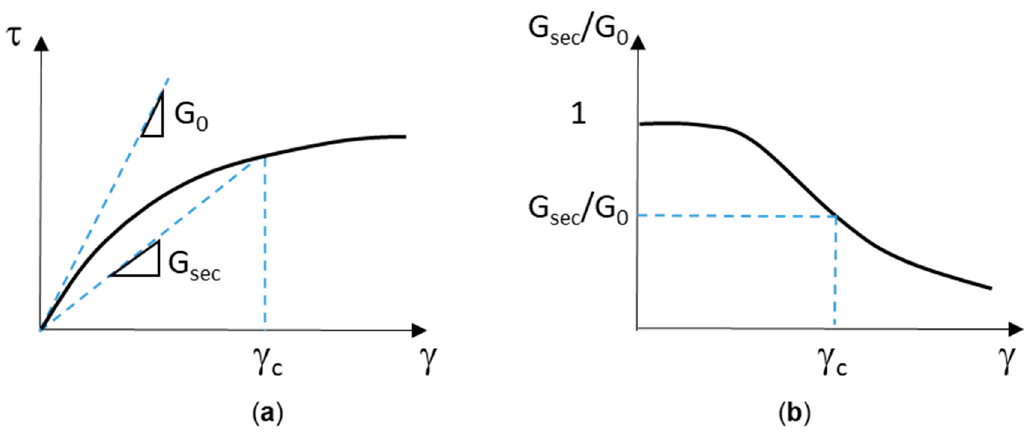
Figure 1. ( a ) Qualitative relation between shear stress, τ , and shear strain, γ and ( b ) normalized shear modulus G sec /G 0 (where G 0 is at small strain) and shear strain, γ .